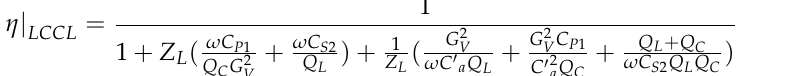
where G V is equal to C c /C S2 , and C’ a , C’ c are expressed in (40). As shown in Equation (51), when the quality factor and impedance of passive elements are fixed, the efficiency of LCCL topology is decided by the load resistance Z L and system operation frequency ω . Hence, the maximum system efficiency can be derived as